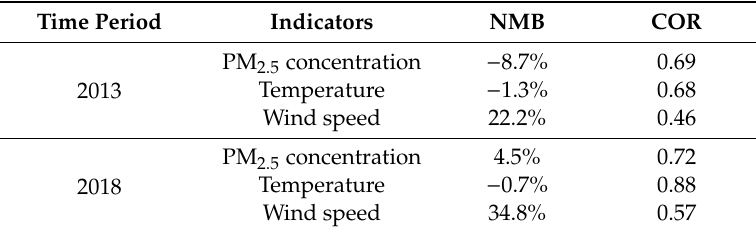
Table 1. Verification of meteorology and air quality simulation e ff ects. NMB, standardized average deviation; COR, correlation coe ffi